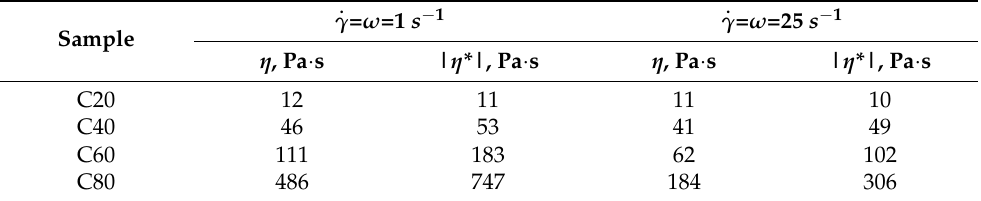
. γ ) and frequencies ( ω ) at 270 ◦ C.